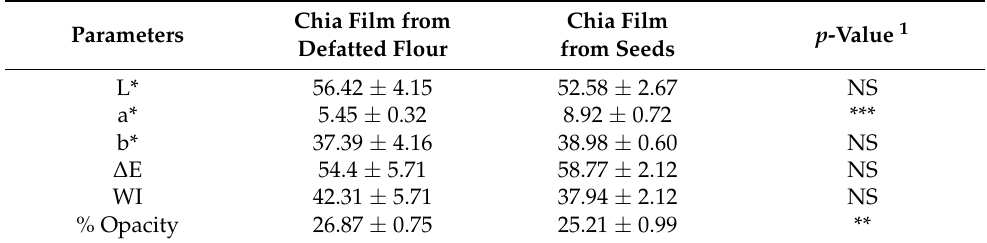
Table 2. Color parameters L*, a*, b*, opacity, and total color difference ∆ E of the chia films made with different matrixes (mean ±